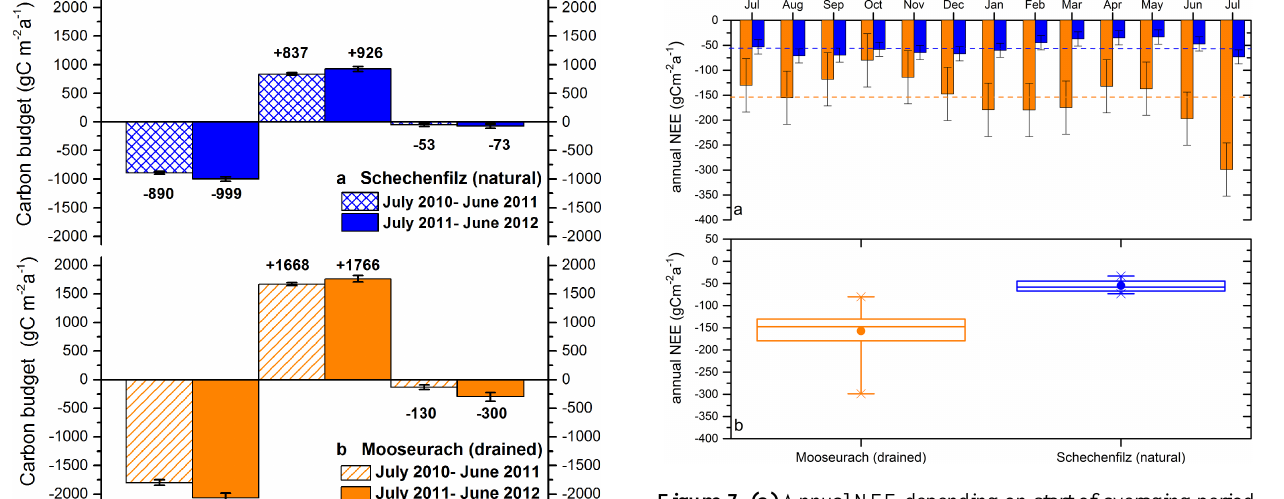
Figure 7. (a) Annual NEE depending on start of averaging period, dashed line illustrates the mean of 13 different averaging periods, the vertical bars present the standard deviation. (b) Box plots illus- trate the range (–) of detected annual sums of NEE and their mean ( • ). The box indicates the 25th, 75th and 50th